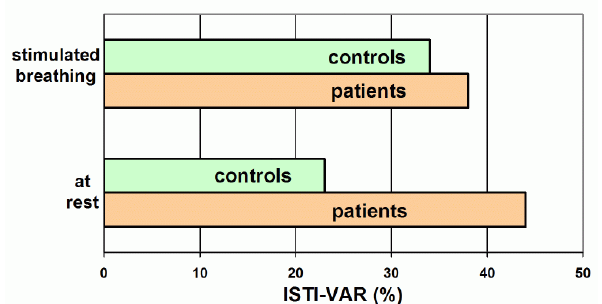
Fig.4: Variability in ISTI (ISTI-VAR) in the group of patients suffering from Parkinson’s disease and in the control group, during normal breathing at rest and during stimulated, deep breathing. At rest there is a significant difference between the two groups. During stimulated deep breathing ISTI-VAR increased significantly in the control group. However, ISTI- VAR did not change significantly in the patient group as it was already substantially